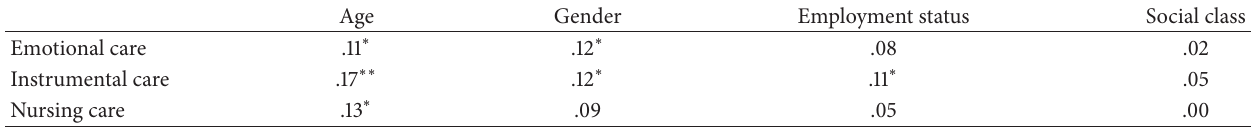
Table 2: Correlations among willingness to provide care and demographic variables.